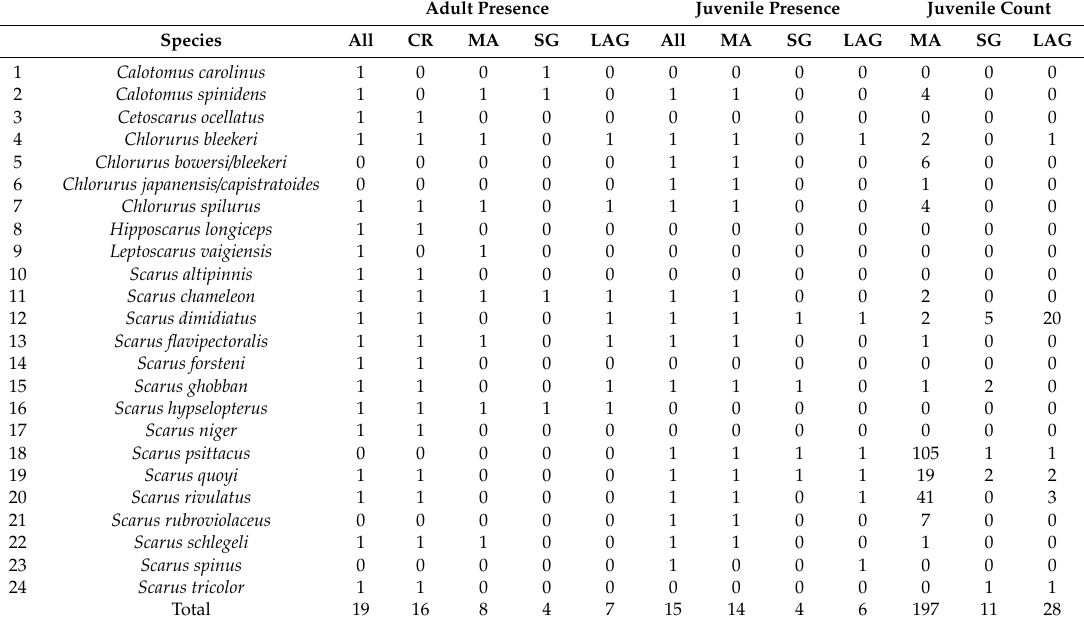
Table 2. Parrotfish (family: Labridae, subfamily: Scarinae) species identified by DNA analysis of juveniles collected in non-reef habitats and species observed as adults on underwater visual census surveys across multiple habitats: 1 = present in surveys or collections, 0 = not observed or identified. Data is separated by juveniles and adults and then also recorded by habitat type. Total count is the total number of each species collected as juveniles in non-reef habitats. All = observed in any habitat on visual surveys, CR = Coral Reef, MA = Macroalgal bed, SG = Seagrass, and LAG =